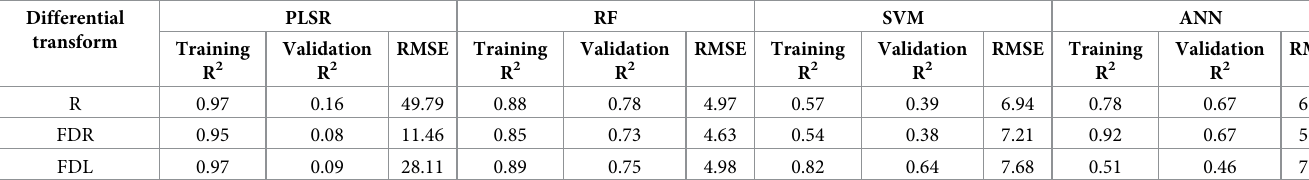
Table 4. Comparison of soil organic matter hyperspectral prediction modeling methods. Differential